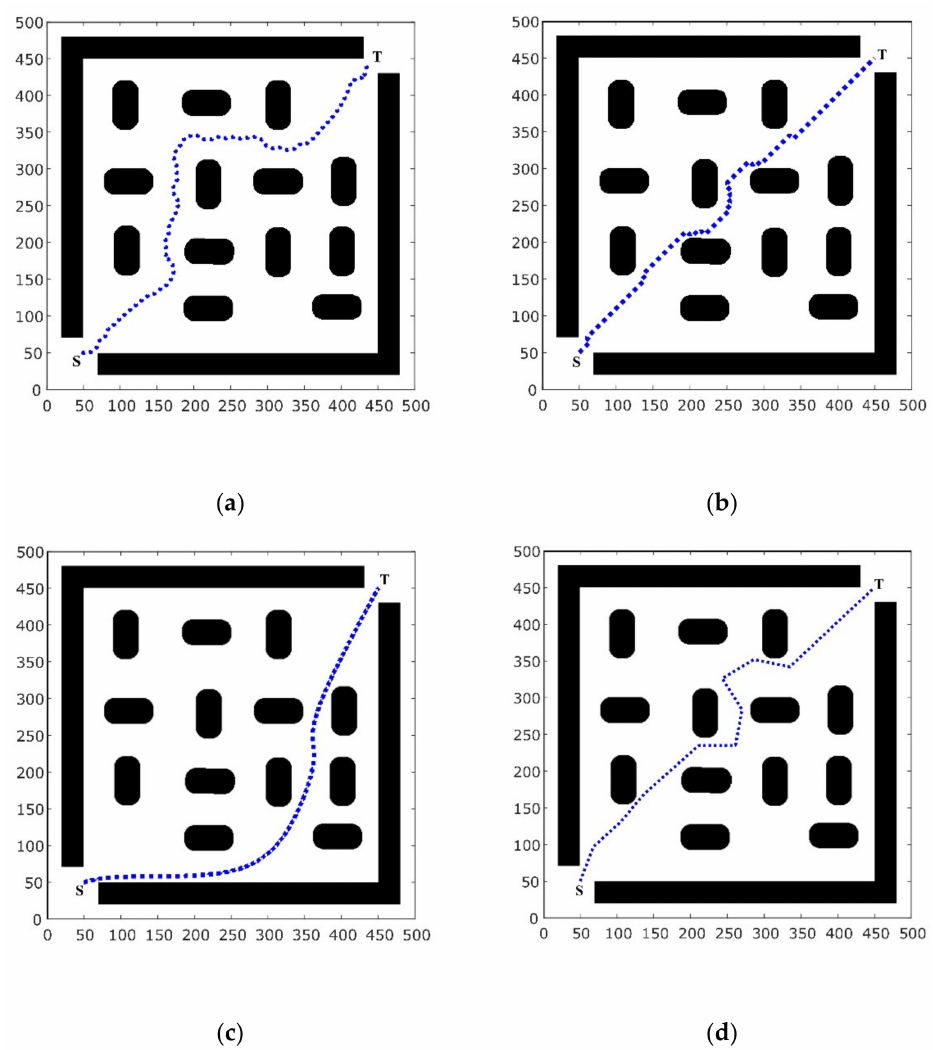
Figure 5. Environment III. The figures contain the simulation paths of the following algorithms: